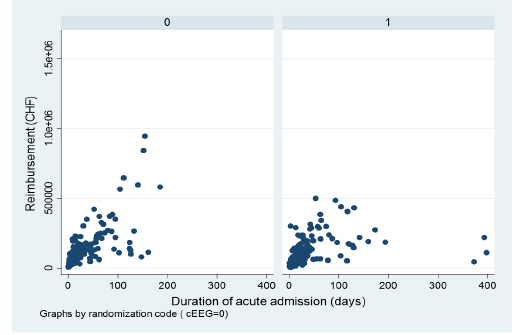
Figure 1: correlation of reimbursement and duration of acute hos- pitalisation stratified for cEEG (left; rho 0.817, p <0.001) and rEEG (right; rho 0.729, p